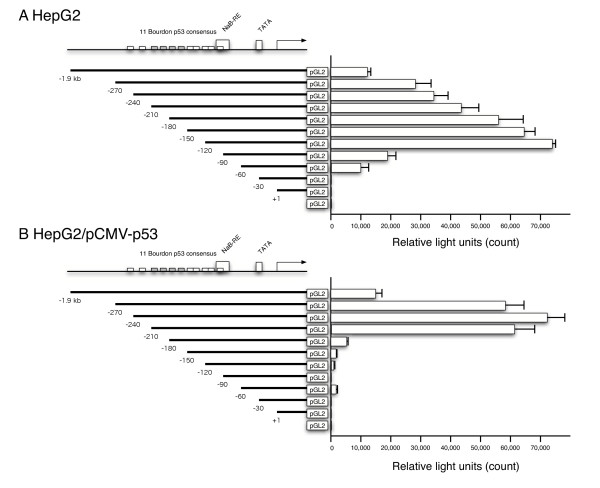
Deletion analysis of IGFBP-3 promoter for the induction by p53. HepG2 cells were transiently transfected with the panel of IGFBP-3 promoter-luciferase reporter constructs with (B) or without (A) co-transfection by pCMV-p53, and luciferase activity was measured after 48 h. Mean count of luciferase activity +/- SEM is shown.